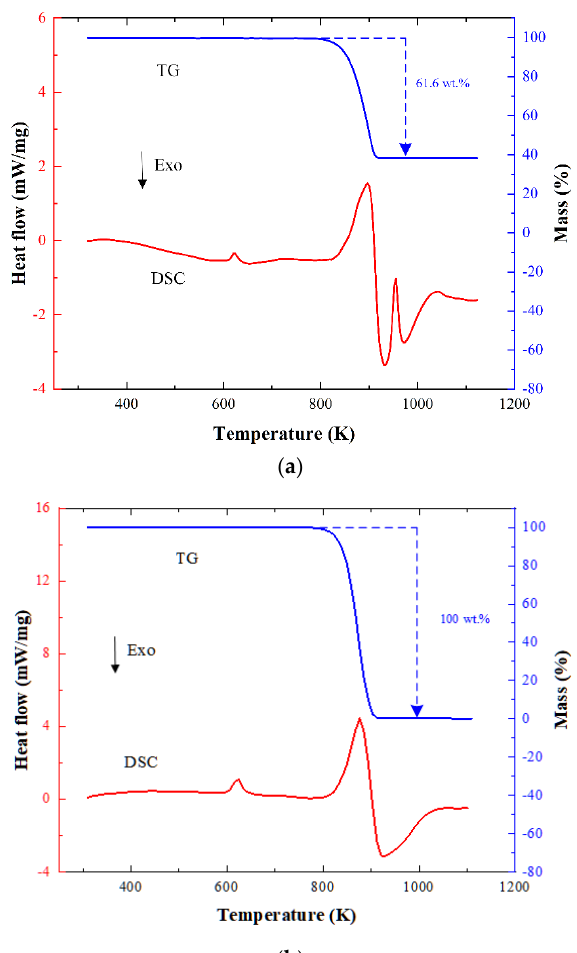
Figure 15. DSC/TG results of ( a ) PTFE/Al reactive composites and ( b ) pure PTFE.